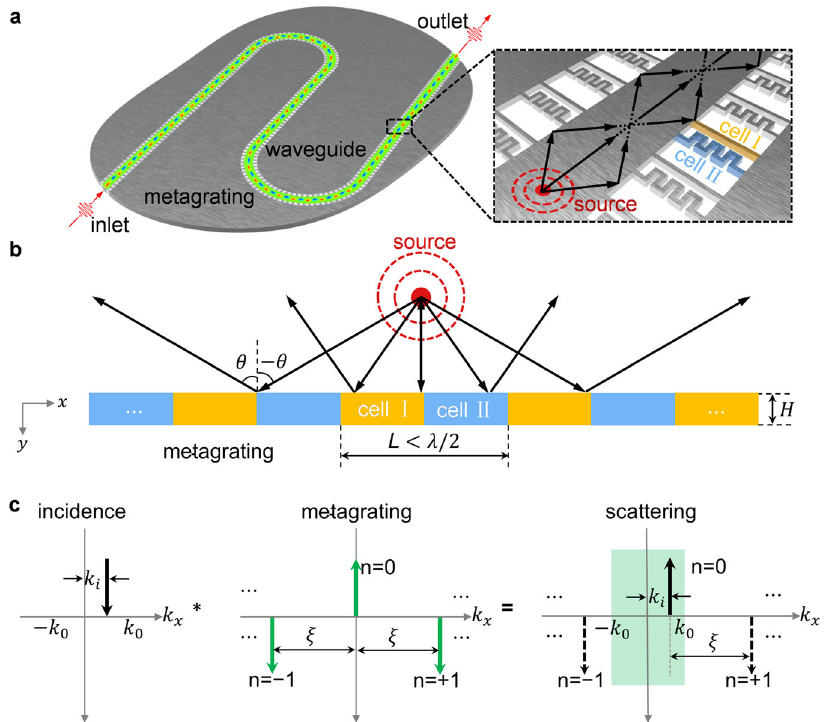
Fig. 1 Metagrating-based ultrathin waveguide. a Schematic of the proposed waveguide constructed by two layers of elastic metagratings to con fi ne the waves along an arbitrary route. The supercell, consisting of only two unit-cells, is periodically distributed in each metagrating. b The metagrating can omnidirectionally block fl exural waves in a thin plate in the form of specular re fl ection. The interval of periodically repeated supercells L is less than half of the wavelength. c A diagram for how the metagrating omnidirectionally re fl ect an incident wave. k x denotes the wavenumber along the metagrating. ξ and n denote reciprocal lattice vector and diffraction order, respectively. The black arrows represent wave vector k x of incident and scattering waves, while green arrows represent wave vector k x from metagrating diffraction. Upward (downward) arrows represent the re fl ection (transmission) of waves. The green box is the regime of propagation modes. The solid arrow in the green box indicates that the 0th order waves can propagate into far fi eld, while the dashed arrows beyond the green box indicate other-order diffraction waves will decay evanescently in the near fi eld. The y -axis represents the direction of wave vector k y